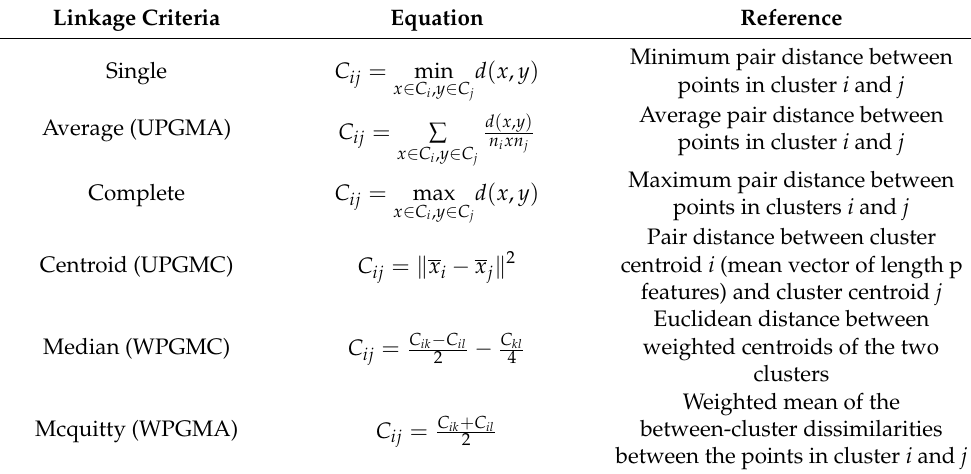
Table 2. Linkage